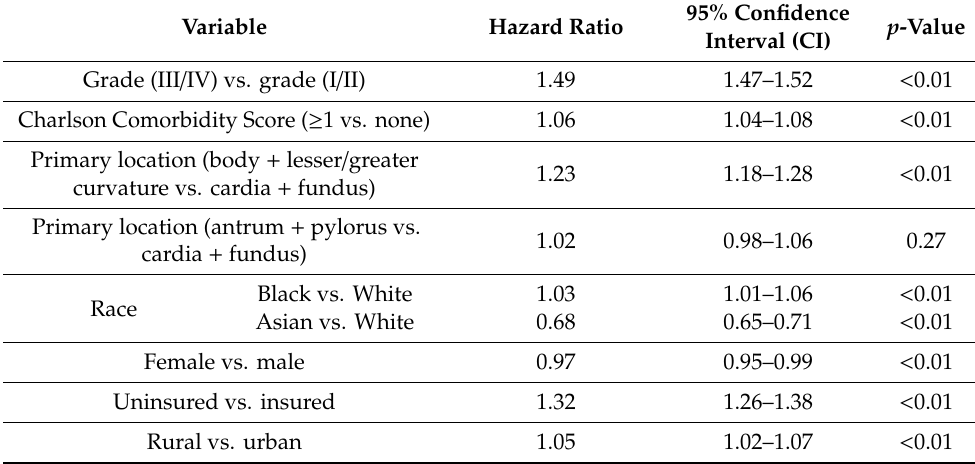
Table 2. Multivariable Cox proportional hazards regression model highlighting OS in the gastric adenocarcinoma patient population.